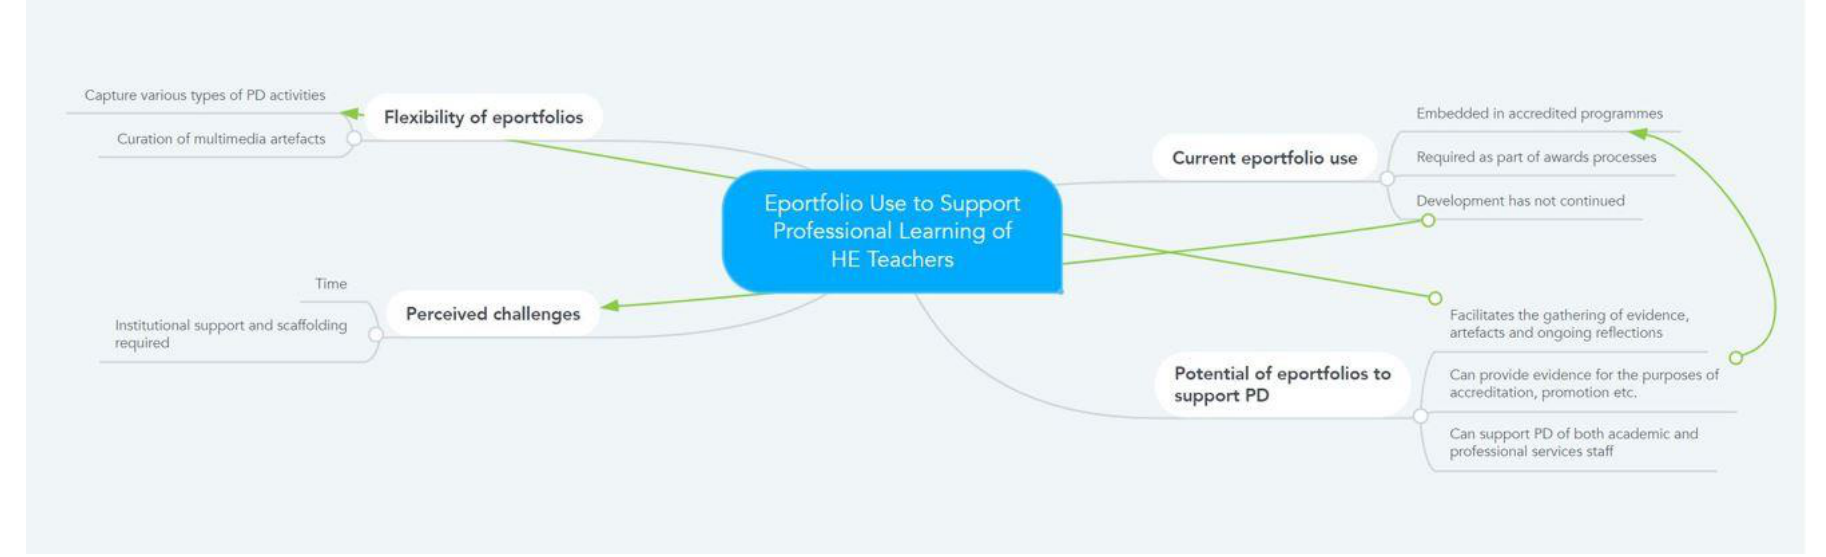
Figure 1: Thematic